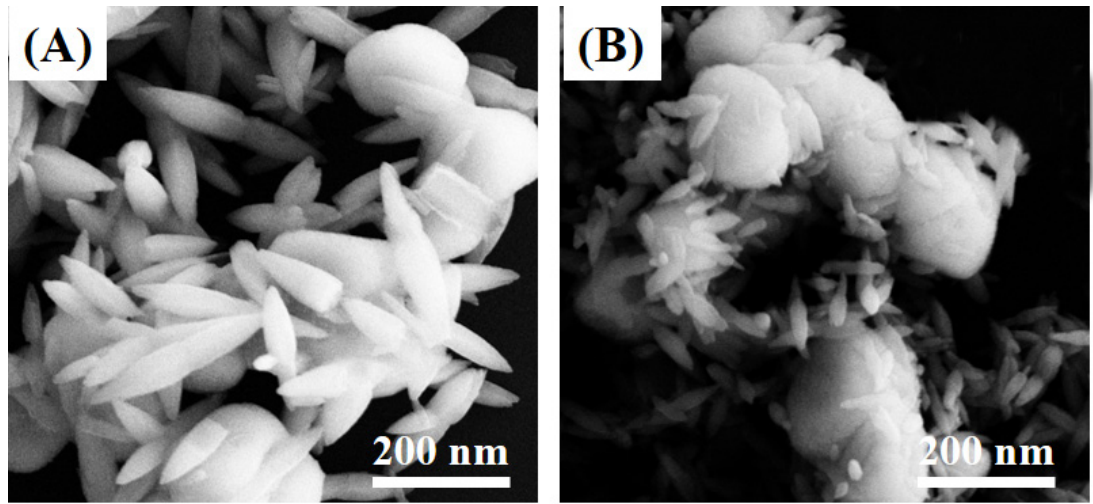
Fig. 1. SEM images of (A) ZnO-AgCl-1 and (B) ZnO-AgCl-3 nanocomposites.